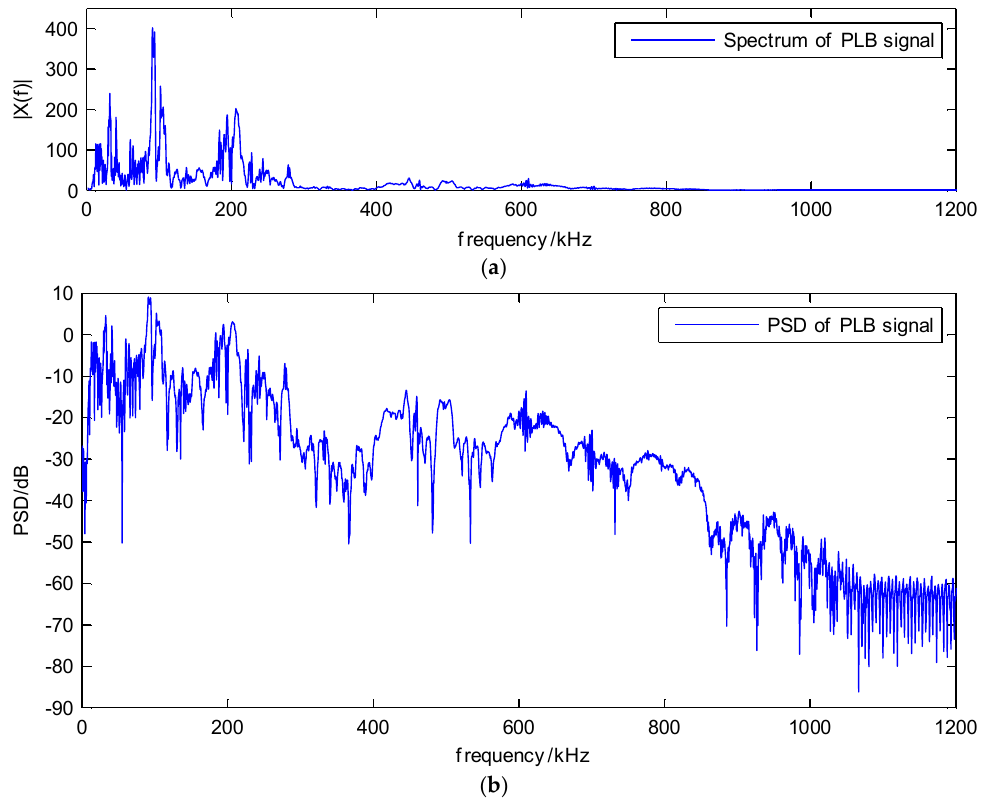
Figure 12. ( a ) The spectrum and ( b ) the PSD of PLB signal. (Include three different main spectrum bands, which are near the 100, 200 and 500 kHz marks).